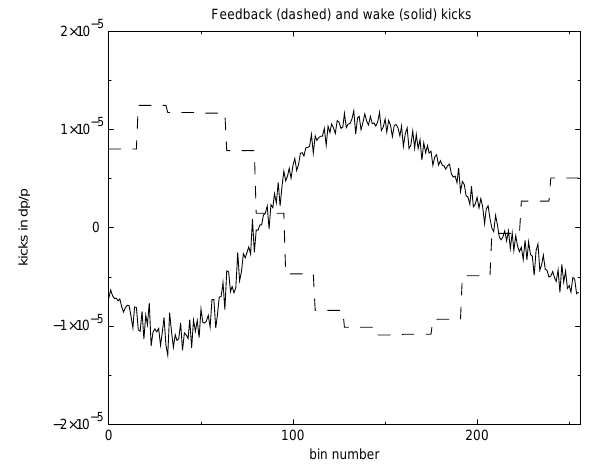
FIG. 6. The kicks from the wakefield and the feedback sys- tem for the case where the feedback kicks the beam 16 times per